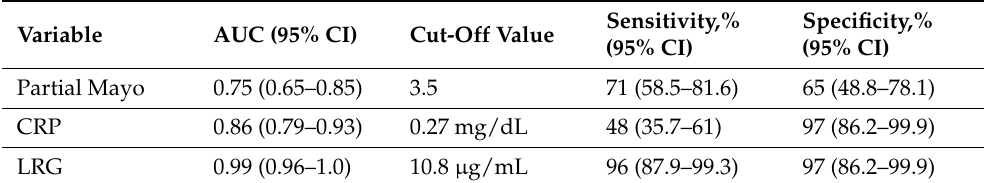
Figure 3. ROC curves for partial Mayo scores ( A ), CRP ( B ), and LRG ( C ) for predicting active ulcerative colitis other than proctitis. Table 4. Area under the curve (AUC), sensitivity, and specificity of partial Mayo score, CRP, and LRG for predicting ulcerative colitis except proctitis.